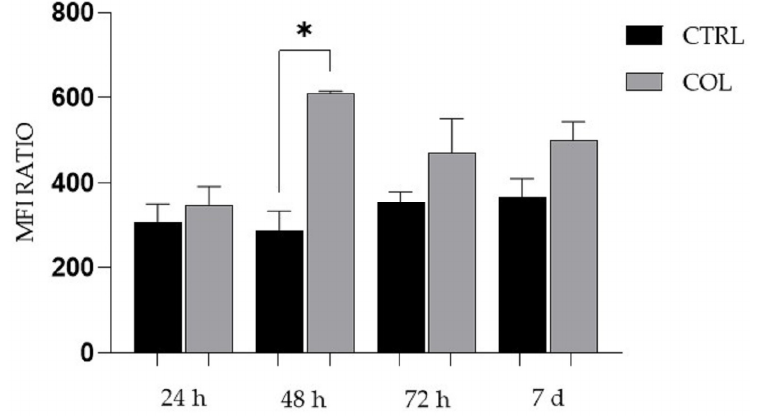
Figure 4. Effect of the collagen coating (COL) on hGF short- and long-term cell vitality at 24 h, 48 h, 72 h, 7 d, and 14 d, in respect to hGF on uncoated cell culture plastic substrates (CTRL). Results are shown as mean fluorescence intensity (MFI) ratio ± standard error (n ≥ 3), obtained by dividing the MFI of positive events by the MFI of negative events (MFI of secondary antibody). (* p < 0.05).